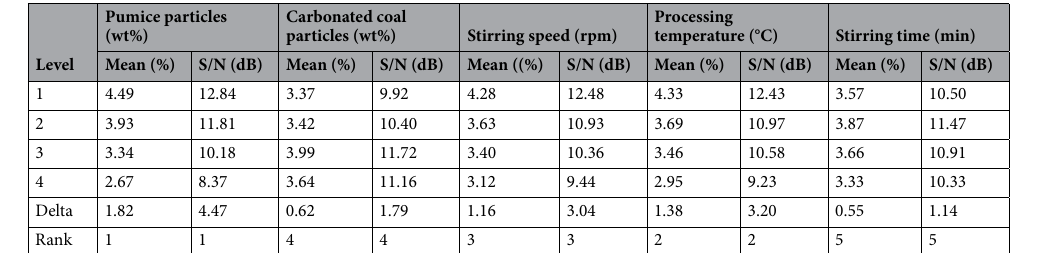
Table 6. Response table for the percentage elongation.